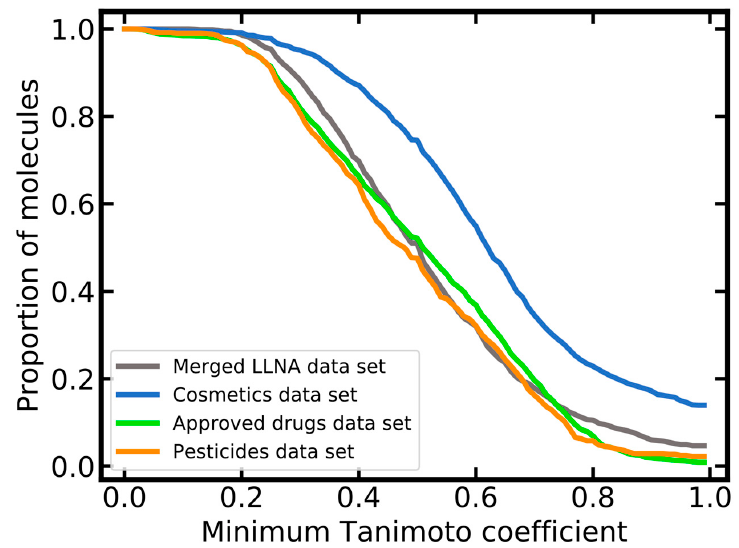
Figure 4. Pairwise molecular similarity within the individual data sets (similarity quantified as Tanimoto coefficient based on Morgan2 fingerprints with a length of 2048 bits).